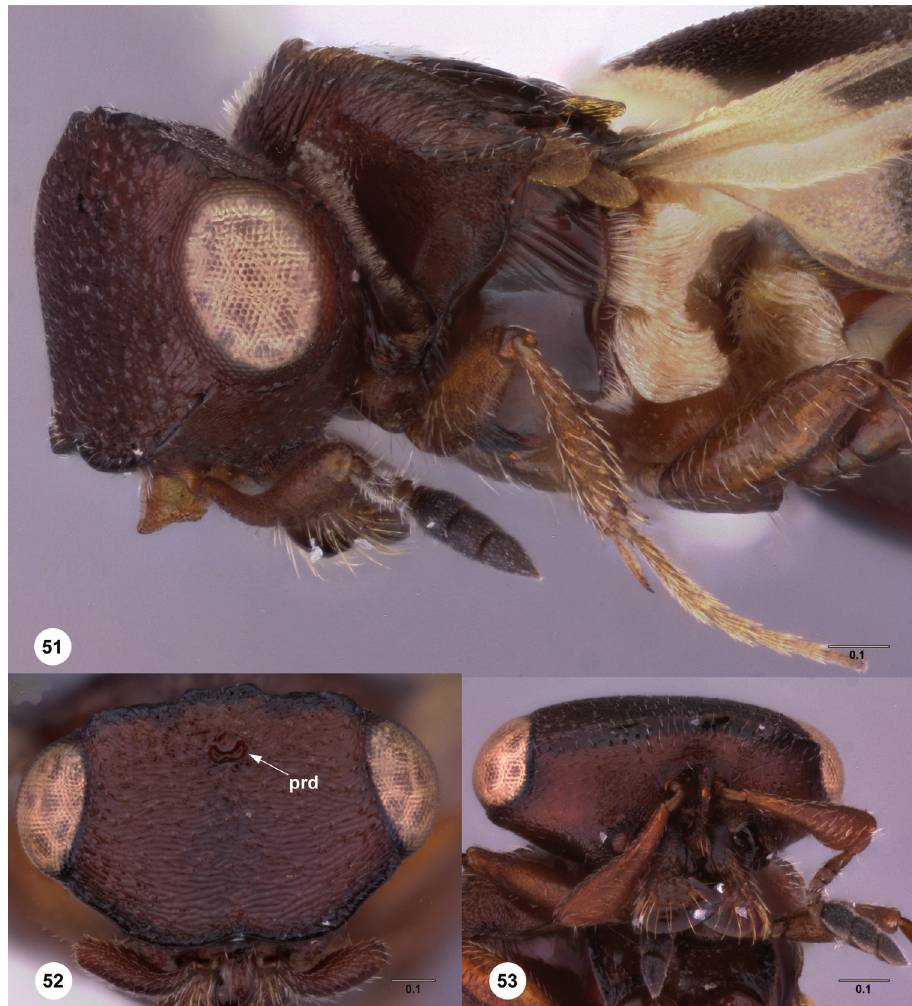
Figures 51–53. Pulchrisolia teras , female holotype (CASENT 2043862) 51 head, mesosoma, lateral view 52 head, anterior view 53 head, anteroventral view. Scale bars in